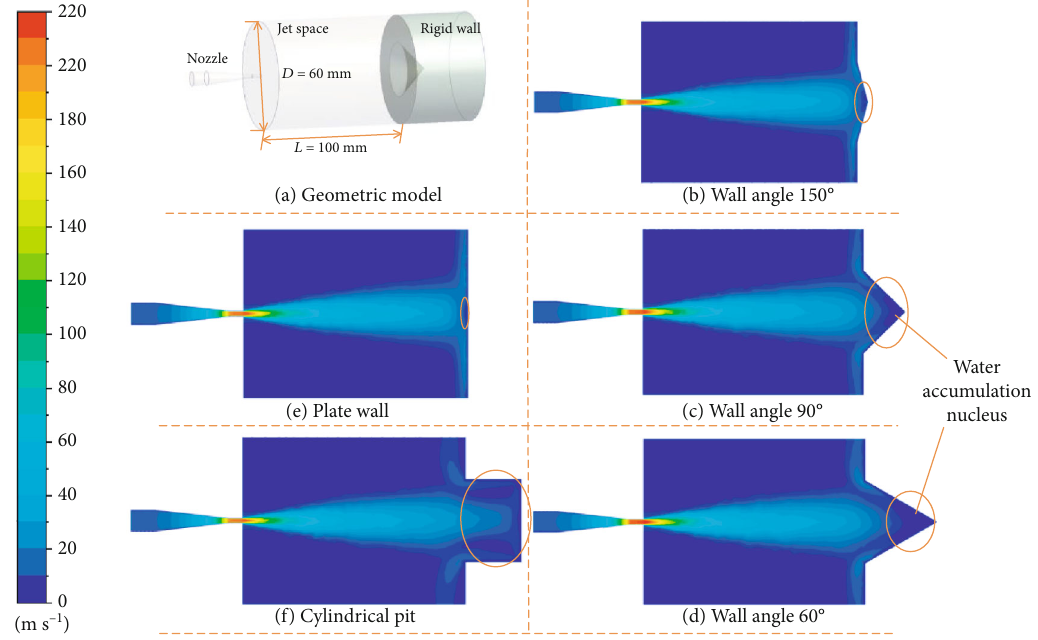
Figure 15: Contour maps of jet velocity in di ff erent coal crushing